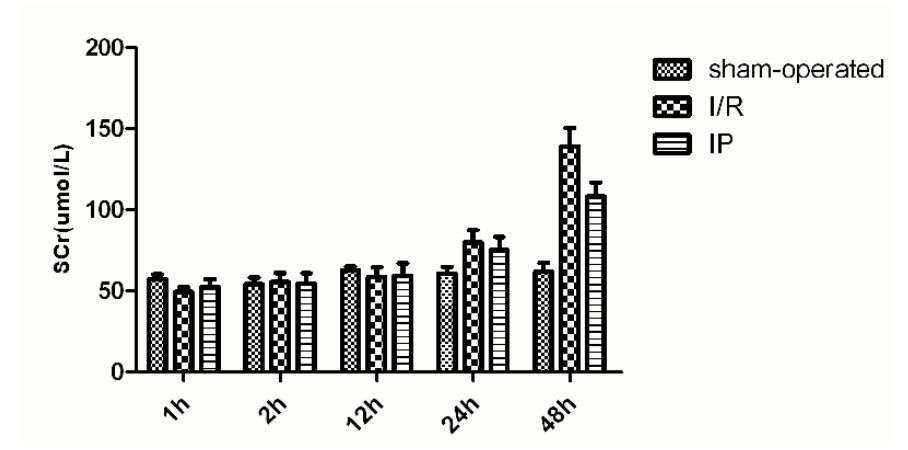
Figure 9 - Changes of serum creatinine after renal ischemic